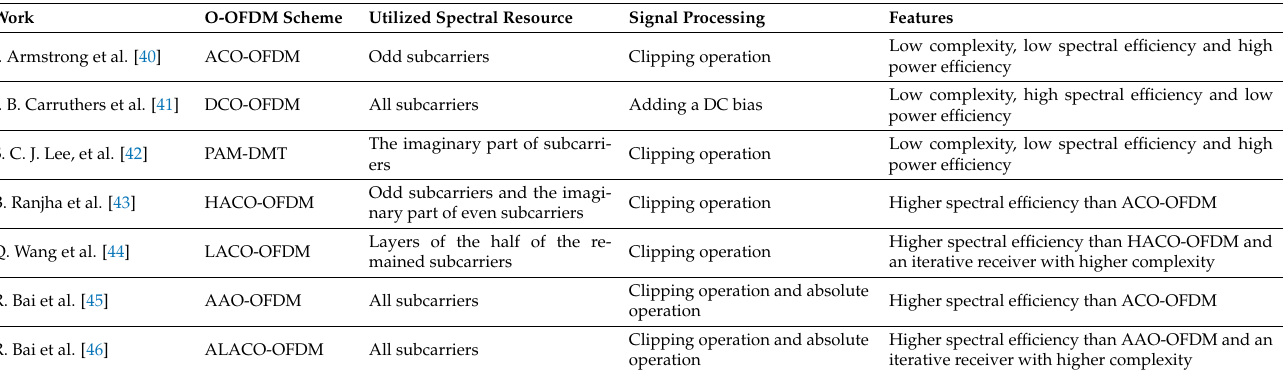
Table 2. Summary of Optical OFDM Schemes in